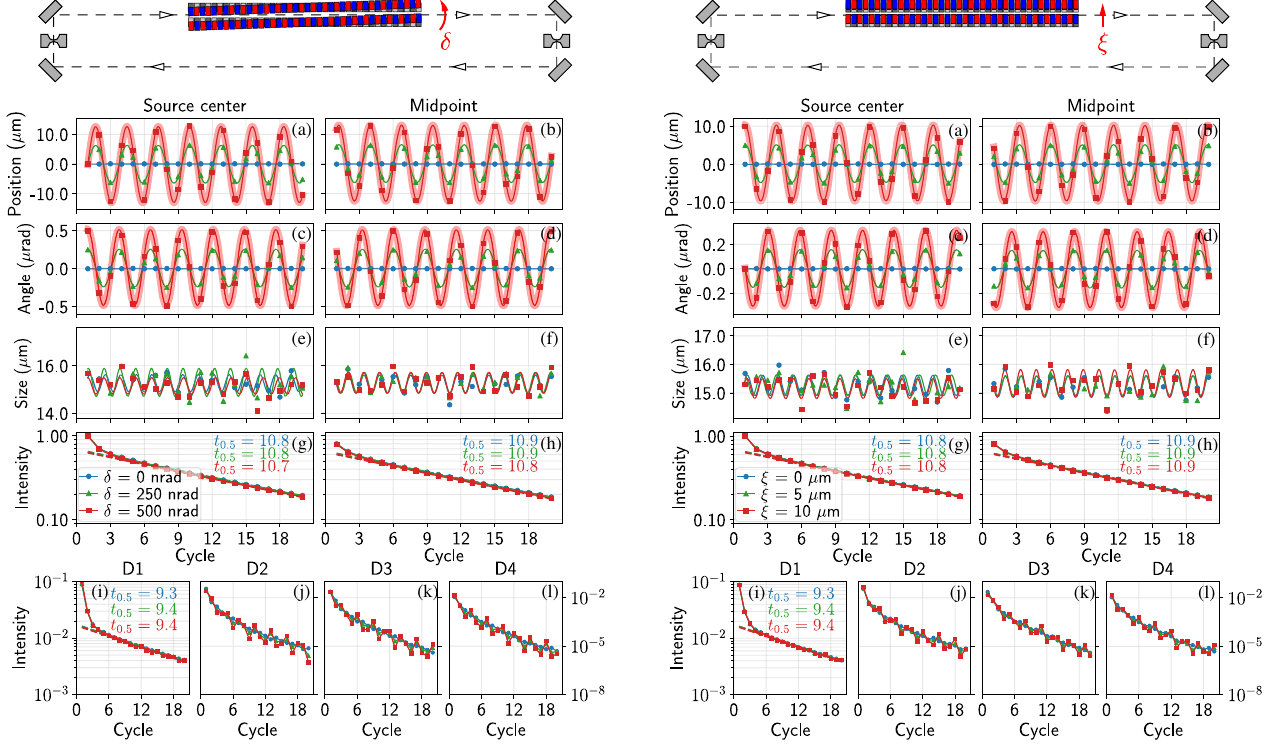
FIG. 19. Simulation results of x-ray beam dynamics in the rectangular four-crystal generic cavity with angle error δ at source.